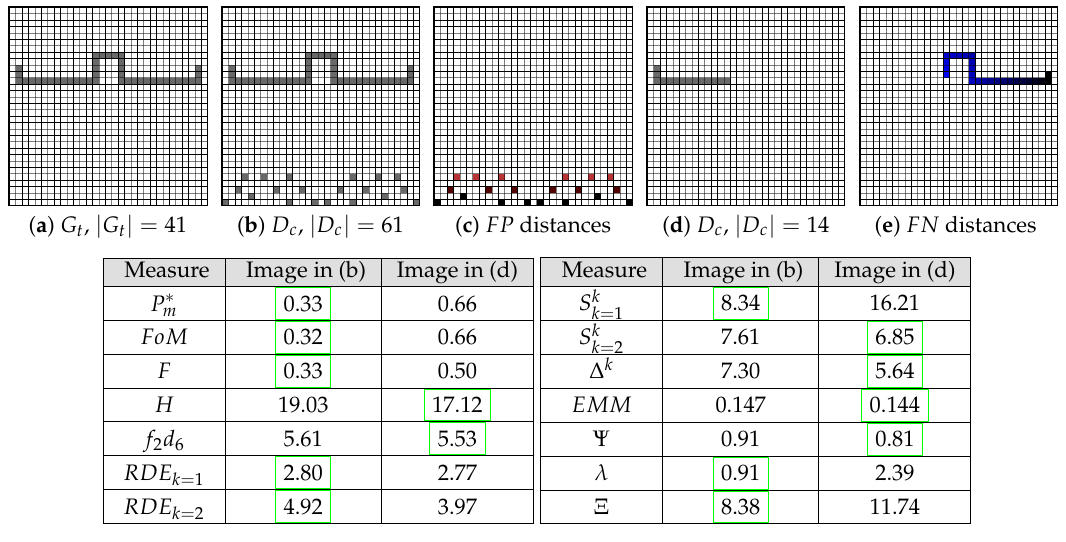
Figure 13. Edge detection evaluations must be more sensitive to FN distances than FP distances. In ( b ), | D c | = 61, so there are 20 FPs, whereas, in ( d ), | D c | = 14, so there are 27 FNs; so FP < FN .